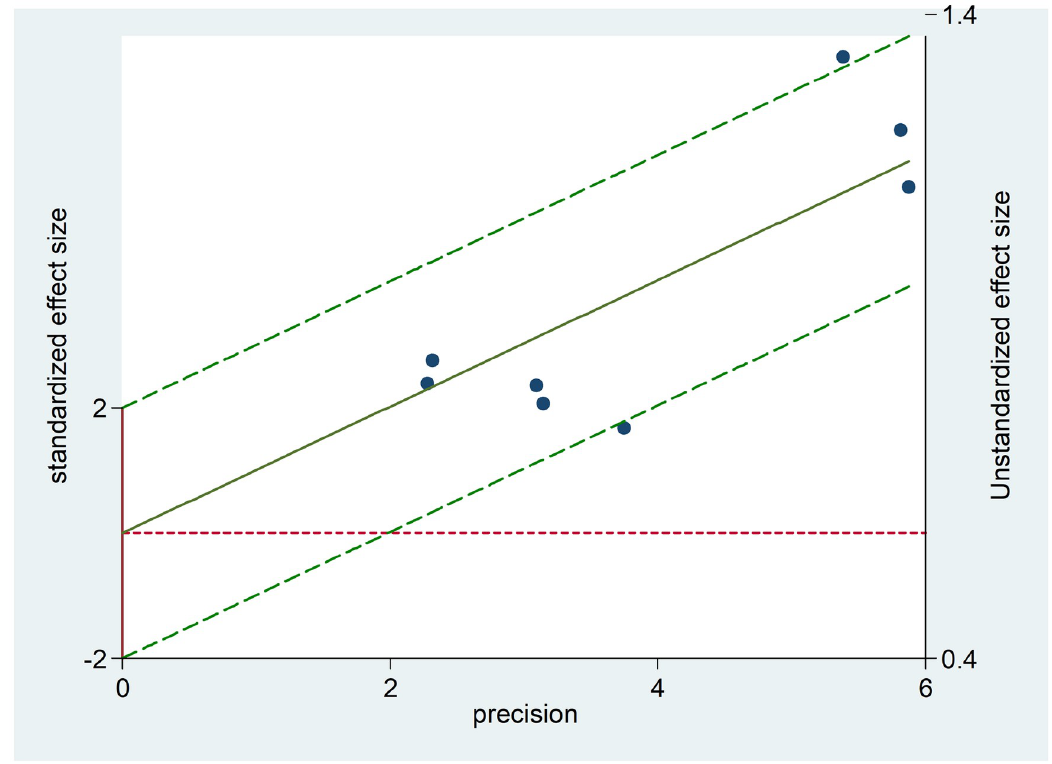
Fig 11. Galbraith diagram for heterogeneity analysis.